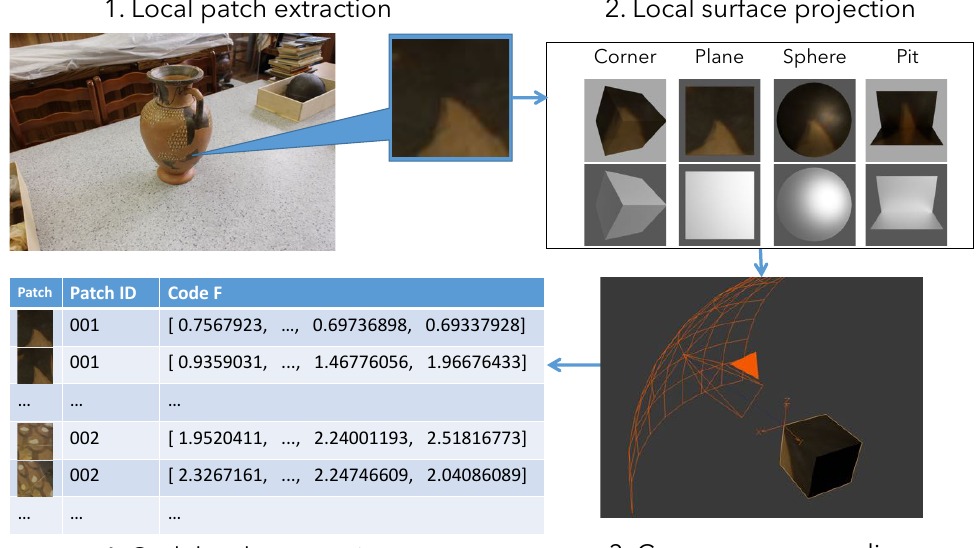
Figure 5. Codebook augmentation